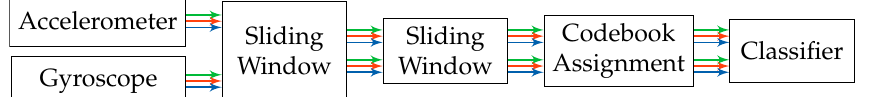
Figure 6. Flow diagram of the pattern recognition pipeline employed during operation of the codebook-based approach. The two sliding windows correspond to the ones employed by the codebook approach for the extraction of sequences and subsequences respectively. Accelerometer and gyroscope each output the three streams x-axis (green), y-axis (blue), z-axis (red), which are processed independently throughout the pipeline until one of the two codebook assignment strategies is used.